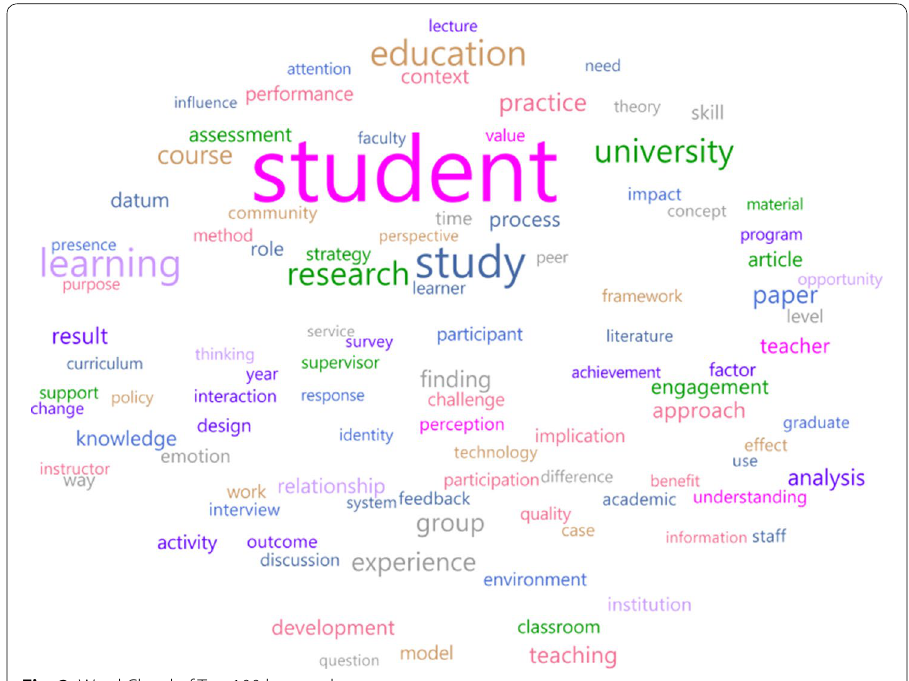
Fig. 2 Word Cloud of Top 100